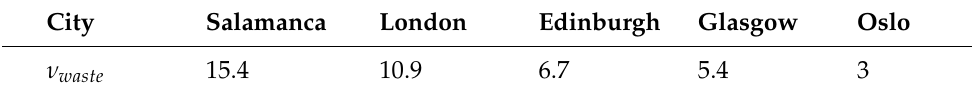
Table 10. Waste impact ratio between RESCATAME and baseline solution.